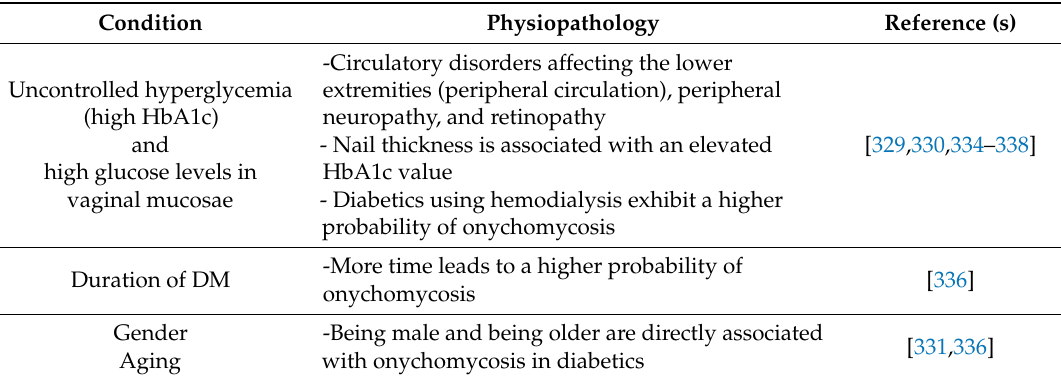
Table 4. Physiopathology and etiology related to the occurrence of nail fungal diseases linked to Candida sp. in